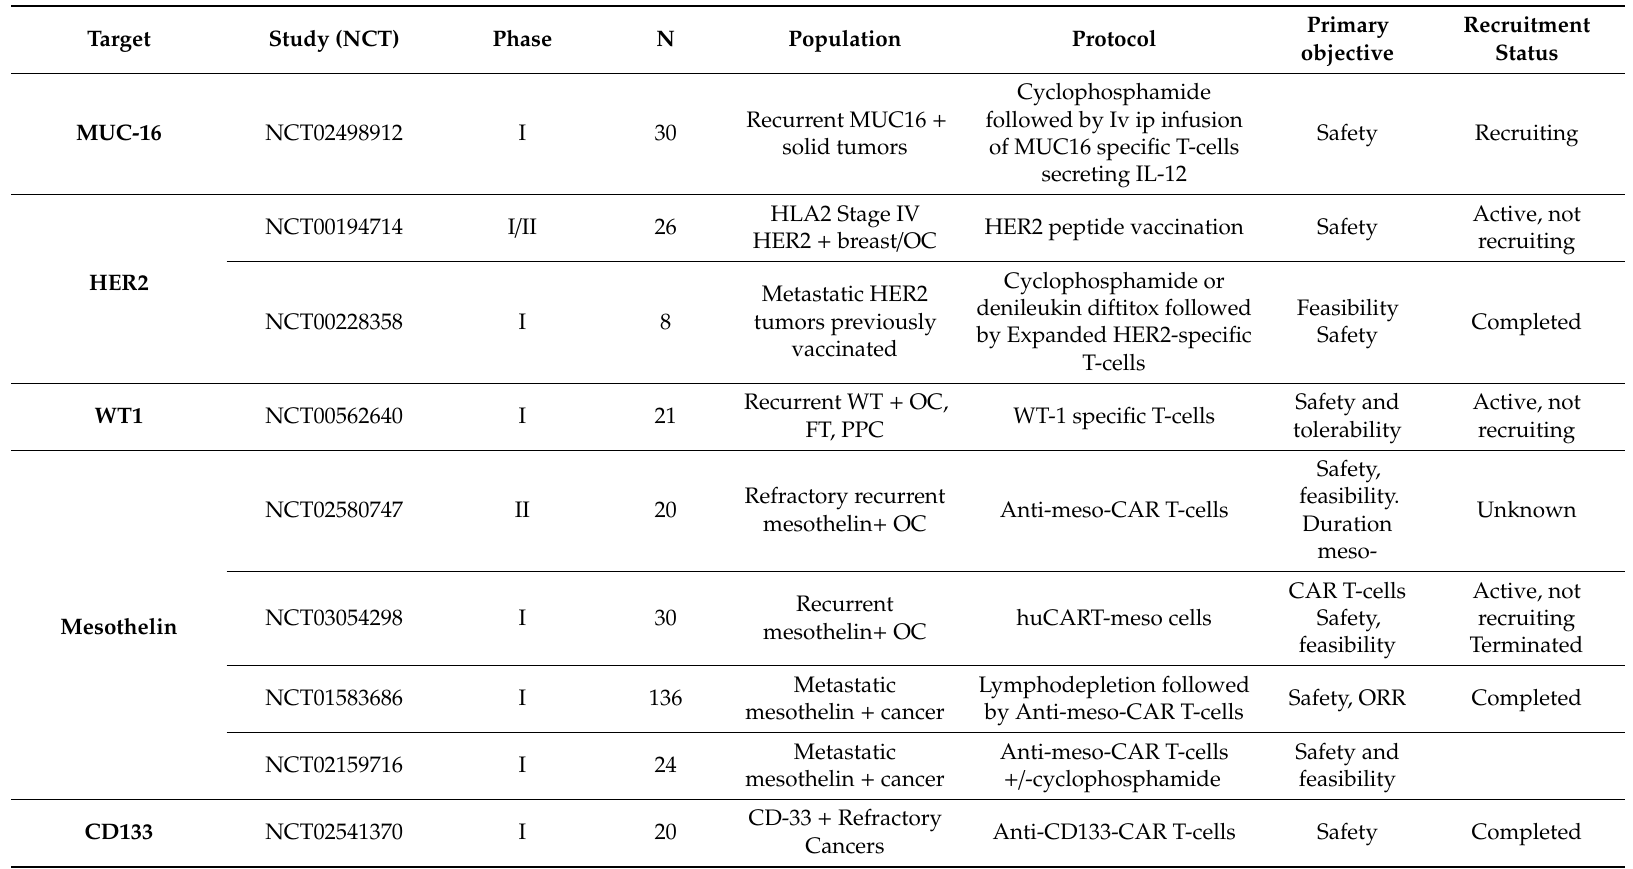
Table 4. Selected ongoing adoptive T-cell